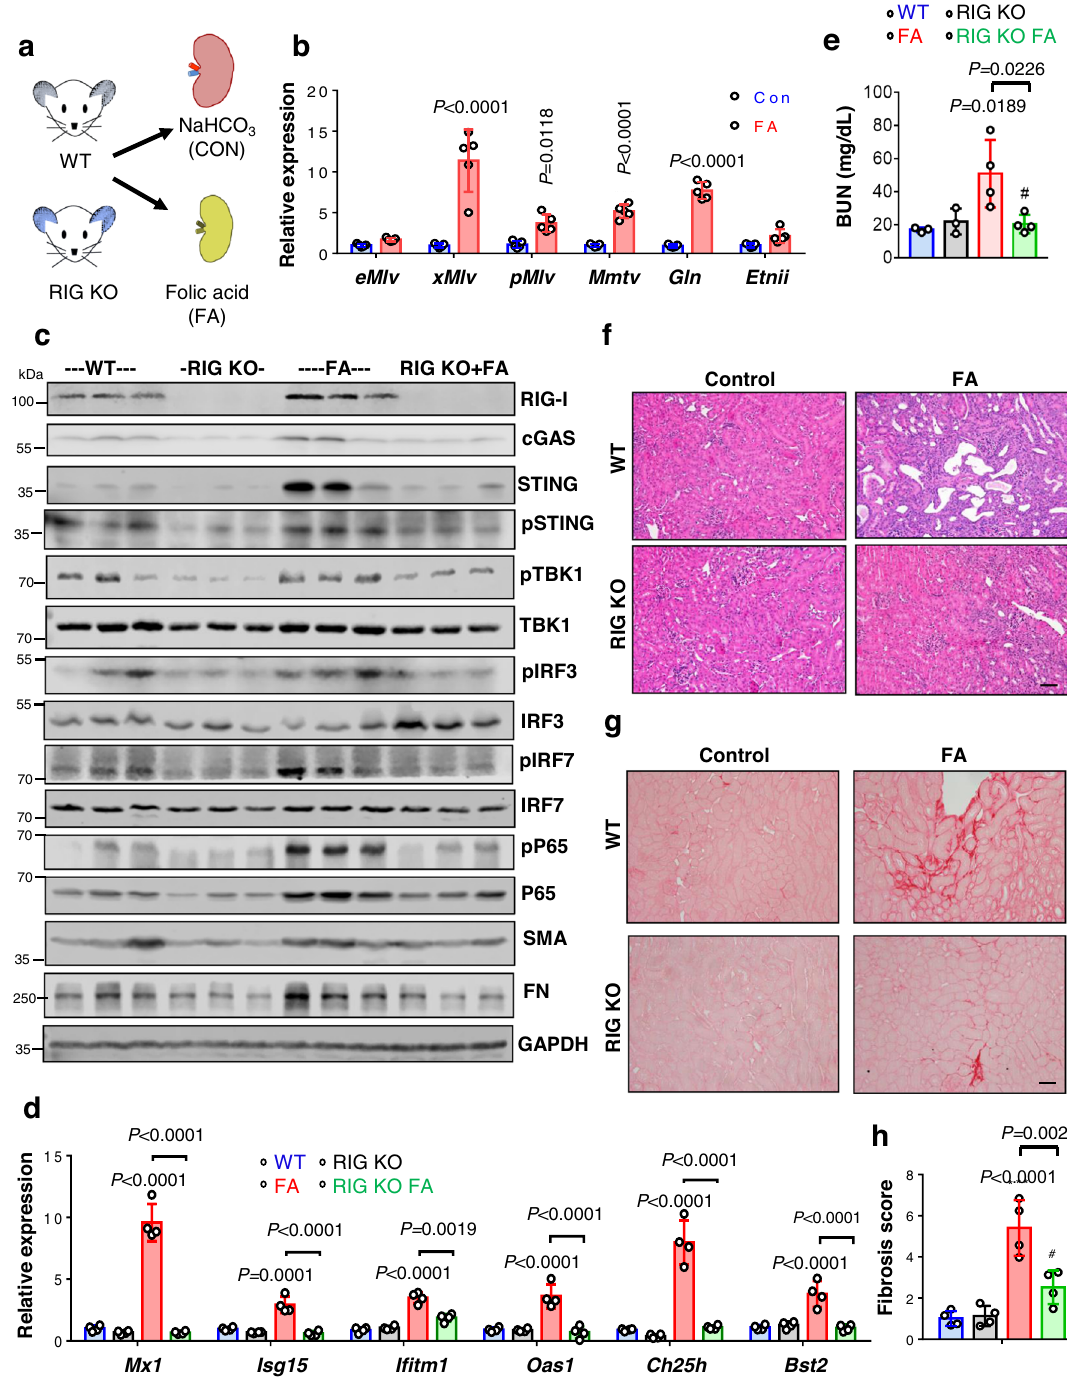
Fig. 7 | RIG-I de fi ciency ameliorates FA-induced kidney fi brosis. a Experimental design: WT and RIG KO mice were injected with FA or vehicle and animals were sacri fi ced on day 7. b Relative mRNA levels of Class I ERVs ( eMlv, xMlv, pMlv , and Mmtv ) and Class II ERVs ( Gln and EtnII) in kidneys of WT mice injected with vehicle (blue) or FA (red) ( n =5 in each). Data were presented as the mean±s.e.m and analyzed by two-tailed unpaired Student ’ s t -test. c Western blots showing repre- sentative images of RIG-I, cGAS, pSTING, STING, pTBK1, TBK1, pIRF3, IRF3, pIRF7 and IRF7, pP65,P65,SMA,and FNprotein levelsin kidneys ofWTandRIG KOmice injectedwithvehicleorFA.GAPDHwasusedasaloadingcontrol. d RelativemRNA levelsofISGs( Mx1,Isg15,I fi tm1,Oas1,Ch25h ,and Bst2 )inkidneysofWTandRIGKO mice injected with vehicle or FA ( n =4 in each). e Blood urea nitrogen (BUN) levels